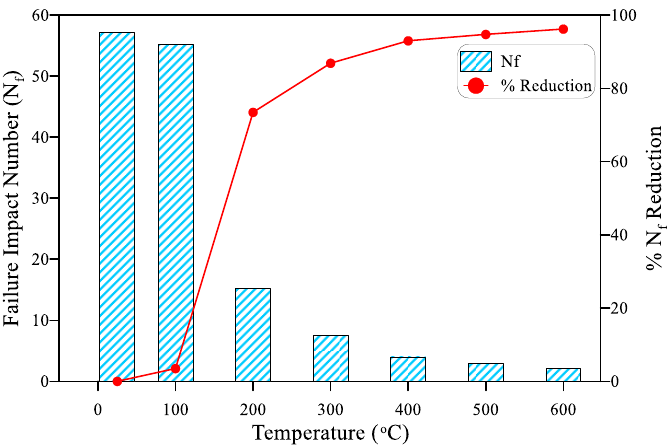
Figure 11. Failure impact number and its percentage reduction at different temperatures.